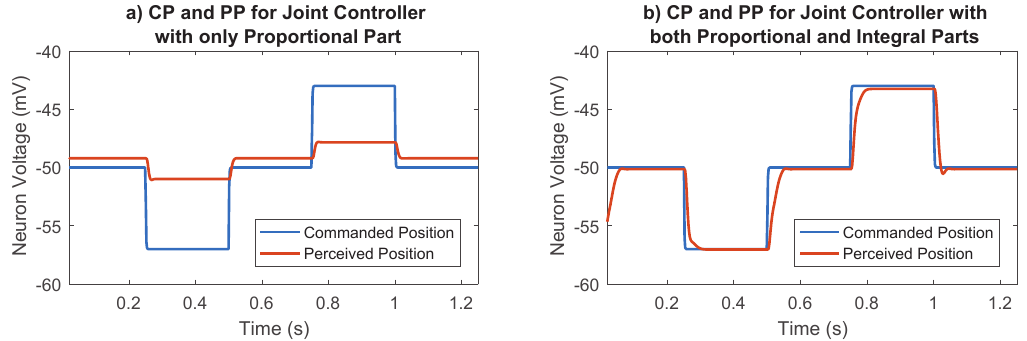
Figure 5. Importance of the integral part in the joint control network. ( a ) Joint controller with integral part disabled. The proportional part alone is not enough to move the joint to the desired position.